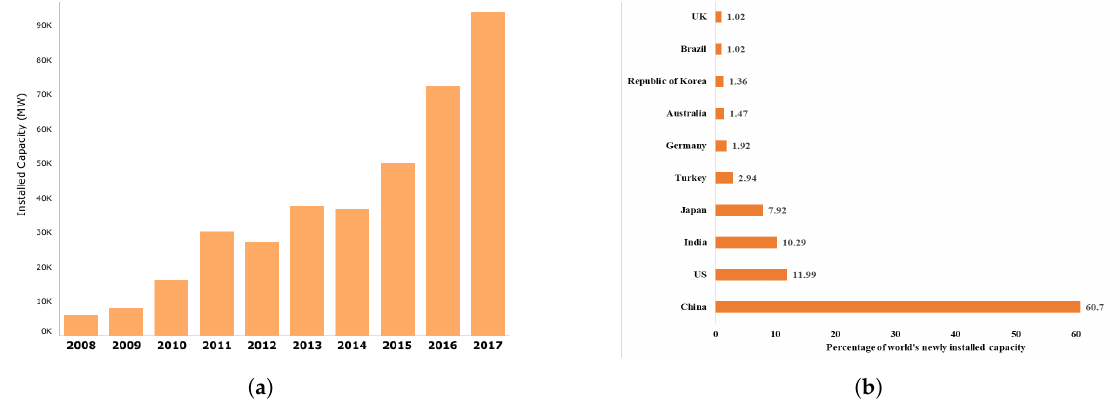
Figure 2. ( a ) Yearly global PV capacity additions [10]; ( b ) % of global PV capacity additions by countries in 2017